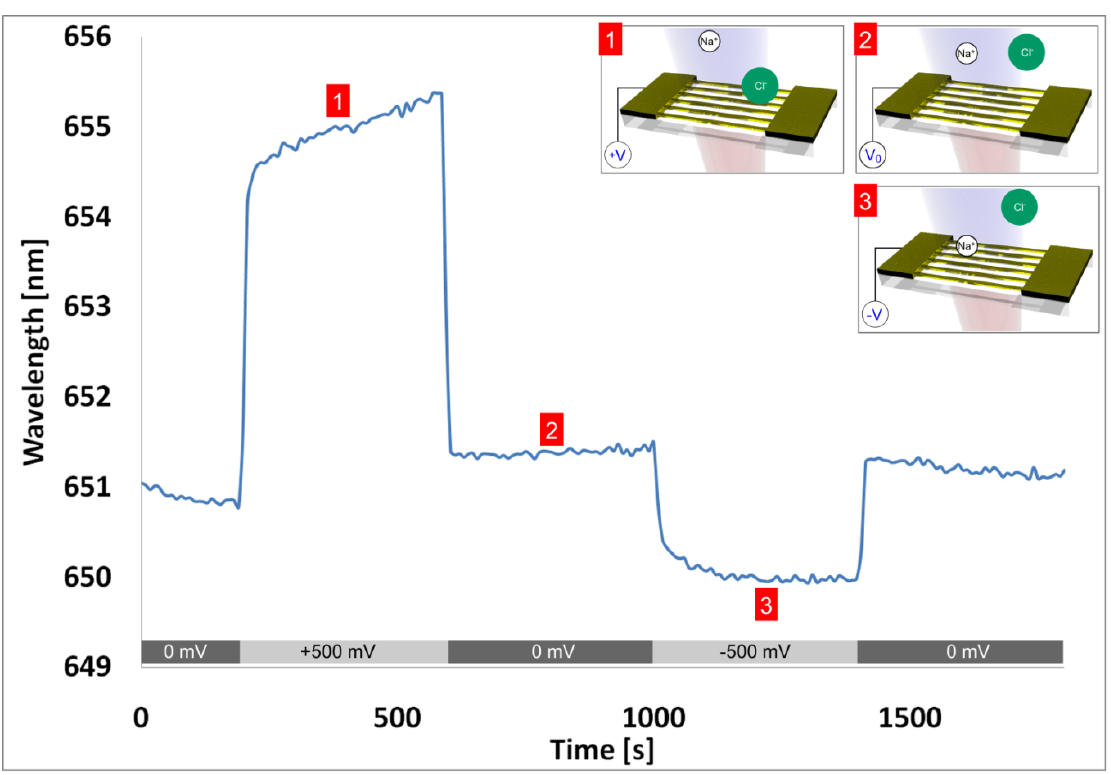
Figure 8. In a 150 mM NaCl solution, voltages of ±500 mV were applied to the nanowire array ( i.e. , working electrode) and regulated by a silver reference electrode and platinum counter electrode. The individual nanowires had widths of 58 nm and heights of 2 nm Cr + 15 nm Au. As illustrated in the inset images, voltages attract the charged ions of opposite polarity to the surface, thereby changing the local refractive index. This change in refractive index is seen as a corresponding shift in the LSPR wavelength of the nanowire